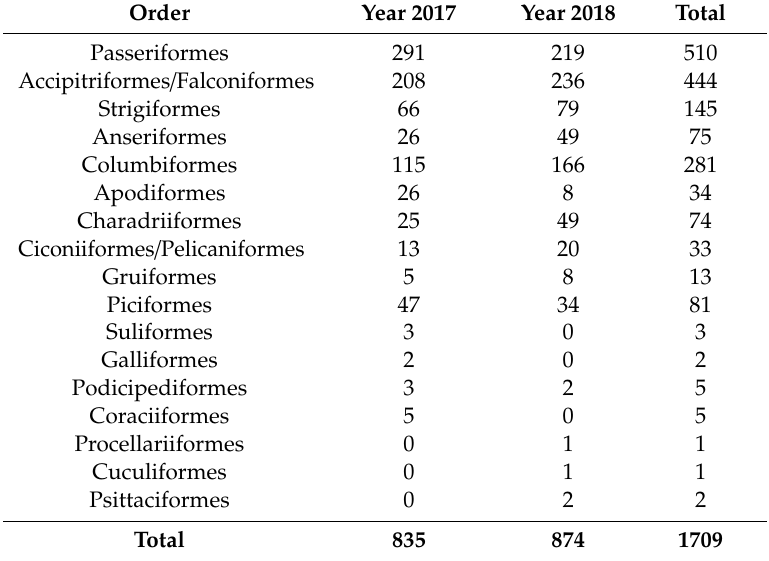
Table 1. Total number of wild bird blood samples investigated between 2017 and 2018 in Germany, divided into bird